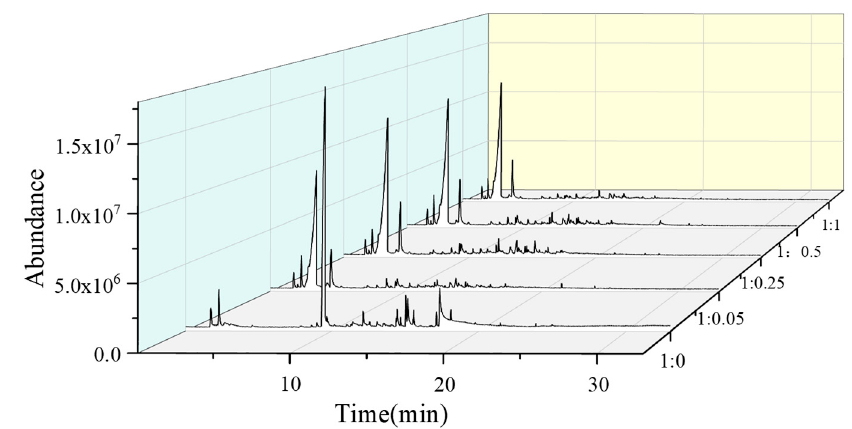
Figure 6. Py-GC / MS total ion chromatograms of fructose and the fructose / KAc mixtures with di ff erent Figure 6. Py-GC/MS total ion chromatograms of fructose and the fructose/KAc mixtures with ratios (1:0.05, 1:0.25, 1:0.5, 1:1) at 350 ◦ C for 30 different ratios (1:0.05, 1:0.25, 1:0.5, 1:1) at 350 °C for 30 s.